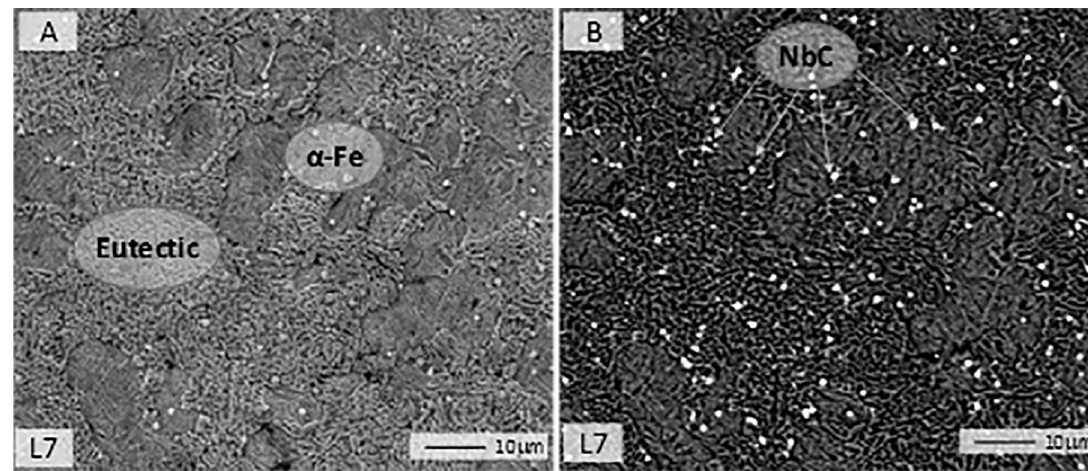
Figure 5. Images of secondary electrons (A) and backscattered electrons (B) of L7 sample.